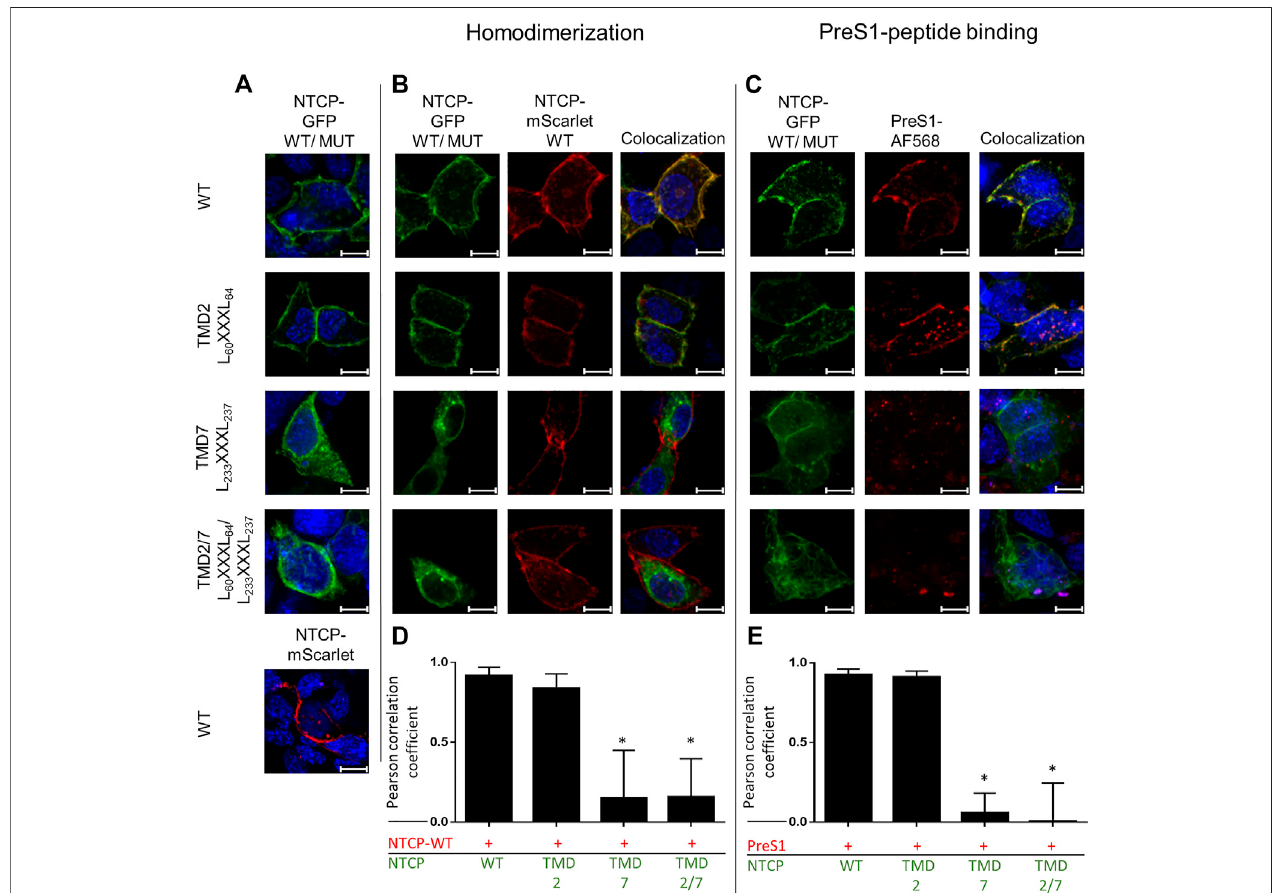
FIGURE2| Colocalizationofthewild-typeandmutantNTCPconstructsinHEK293cells.HEK293cellswereseededoncoverslipsandwere (A) mono-transfected with the indicated wild-type or mutant NTCP-GFP constructs (green fl uorescence) or were (B) co-transfected with wild-type NTCP-mScarlet (red fl uorescence). After 48 h, slides were analyzed by fl uorescence microscopy. Colocalization is indicated by fl uorescence overlay (yellow). (C) Wild-type or mutant NTCP-GFP transfected HEK293 cells were incubated with 50 nM of the HBV/HDV-derived preS1-AF568 peptide for 20 min. After three washing steps with PBS, cells were subjected to fl uorescence microscopy. Images represent maximum projections of z-stacks after deconvolution at 630 x magni fi cation. Nuclei are indicated in blue, scale bars represent 10 µm. The Pearson correlation coef fi cient for the fl uorescence overlay was determined (D) for NTCP homodimerization and (E) for preS1-AF568 peptide bindingby measuring 10 representativeindividual cellswiththe Leica software LAS X.Data represent means ± SD. *Signi fi cantly different from control (NTCP-GFP(WT)- NTCP-mScarlet (WT) or NTCP-GFP(WT)-preS1-AF568) with p < 0.001 (one-way ANOVA with Dunnett ’ s multiple comparison test).